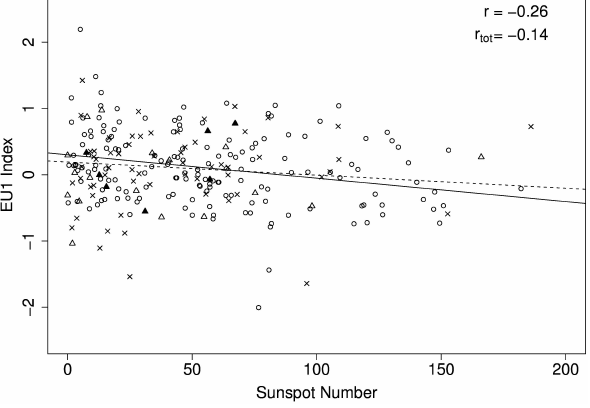
Fig. 4. Scatter plot of the sunspot number versus the EU1 in- dex reconstructed by Luterbacher et al. (1999); both are seasonal (JFM) mean over the period 1749–1990. Triangles represent vol- canic years, while crosses represent ENSO years; filled triangles are both volcanic and ENSO years. The dashed line is the least squares regression line considering every data point, while the continuous line is for “neutral” years only (no volcanic and no ENSO years); the respective Pearson’s coefficients r tot and r are also